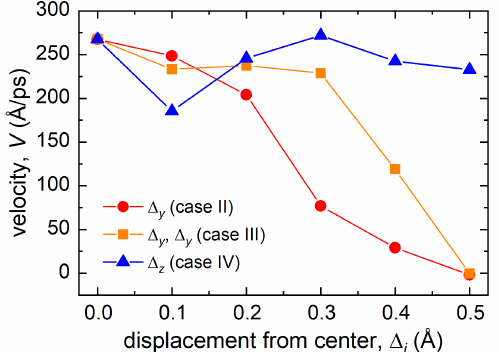
Figure 7. Dependence of velocity of the bombarding atom on the displacements of the atom (cases II–IV). The results are presented for the time instant of t = 0.25 ps and the initial velocity of 450 Å/ps. The lines connecting the data points are guides to the